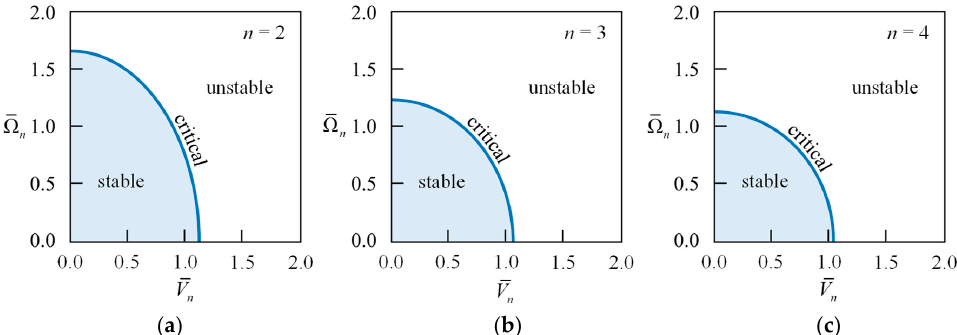
Figure 2. The stable regions, given by Equation (30), of the rotating ring under a uniformly distributed electrical field, wherein both abscissa and ordinate are normalized to be dimensionless rotational speed Ω(cid:3365) (cid:3041) = Ω (cid:2033) (cid:3033)(cid:3041) ⁄ and dimensionless voltage (cid:1848)(cid:3364) (cid:3041) = (cid:3493)(cid:2013)(cid:1848) (cid:2870) (cid:2025)ℎ(cid:1859) (cid:2871) ⁄ (cid:2033) (cid:3033)(cid:3041) (cid:3415) . ( a ) n = 2; ( b ) n = 3; ( c ) n = 4.